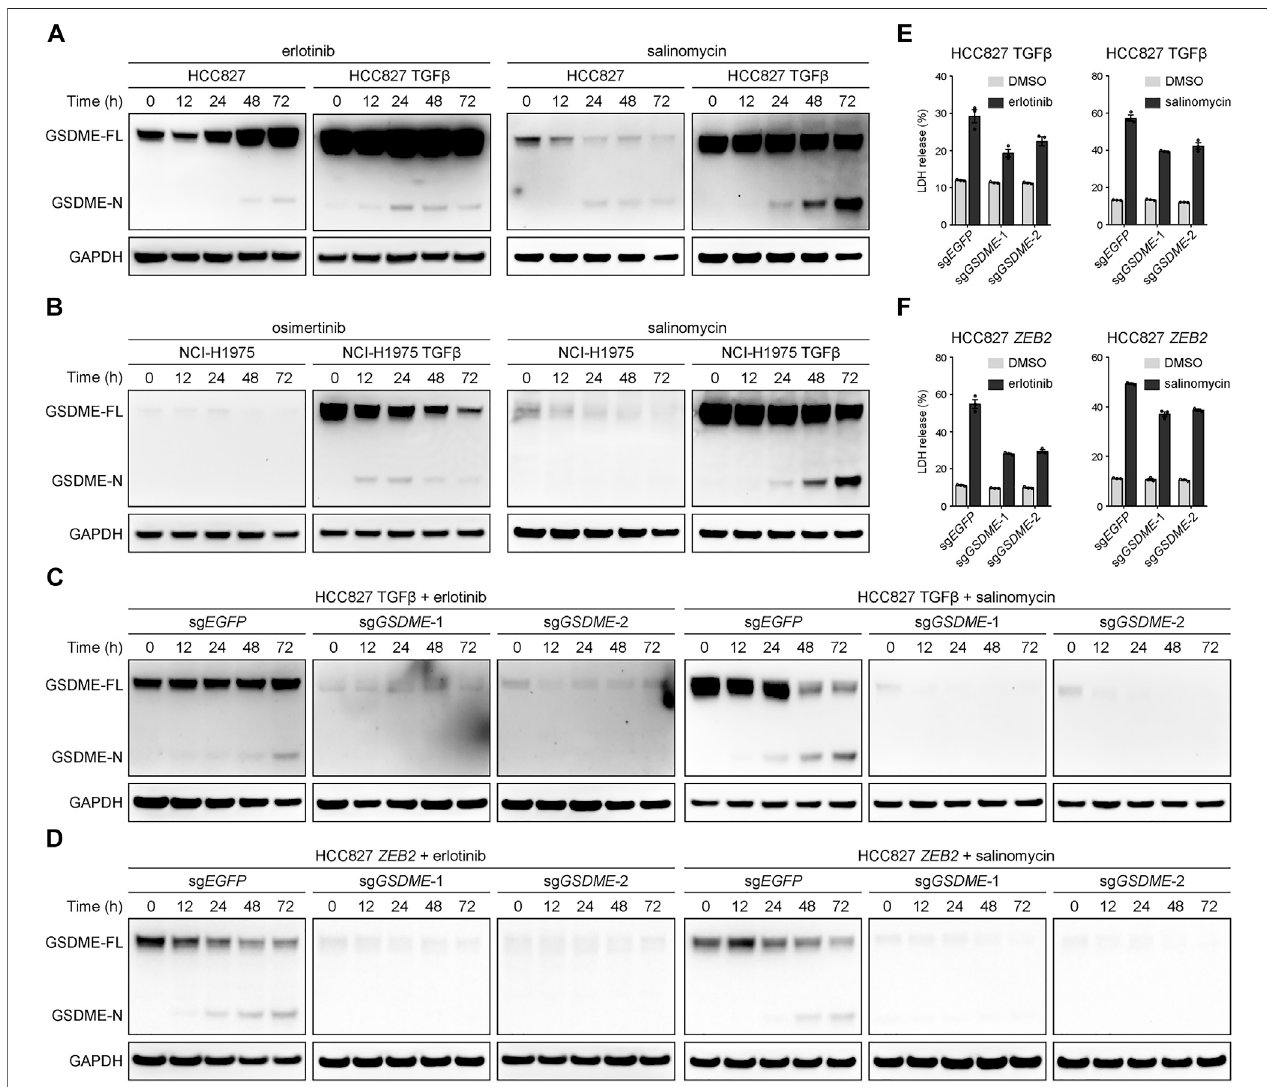
FIGURE 4 | GSDME-dependent pyroptosis in mesenchymal cells upon drug treatment. (A) Parental and TGF β -stimulated HCC827 cell lines were treated with erlotinib (4 μ M) or salinomycin (4 μ M) at a time course manner and analyzed by Western blot for GSDME protein cleavage. GSDME-FL, full-length GSDME; GSDME-N, GSDME N-terminal domain. (B) Parental and TGF β -stimulated NCI-H1975 cell lines were treated with osimertinib (4 μ M) or salinomycin (4 μ M) at a time course manner and analyzed by Western blot for GSDME protein cleavage. (C) GSDME wasknocked out in HCC827 cells using the CRISPR-Cas9 system. Cells were stimulated with TGF β (5 ng/ μ l) to induce EMT, treated with erlotinib (4 μ M) or salinomycin (4 μ M), and analyzed by Western blot for GSDME protein cleavage. (D) GSDME was knocked out in HCC827 cells using the CRISPR-Cas9 system. Cells were transfected with exogenous ZEB2 to induce EMT, treated with erlotinib (4 μ M) or salinomycin (4 μ M),andanalyzedbyWesternblotforGSDMEproteincleavage. (E) GSDME wasknockedoutinHCC827cellsusingtheCRISPR-Cas9system.Cellswerestimulated with TGF β (5 ng/ μ l) to induce EMT, and LDH release in the presence of DMSO or indicated inhibitors was measured. Data are means ± SEM pooled from three independentexperiments. (F) GSDME wasknockedoutinHCC827 cellsusingtheCRISPR-Cas9system.Cellsweretransfectedwithexogenous ZEB2 toinduce EMT, and LDH release in the presence of DMSO or indicated inhibitors was measured. Data are means ± SEM pooled from three independent experiments.